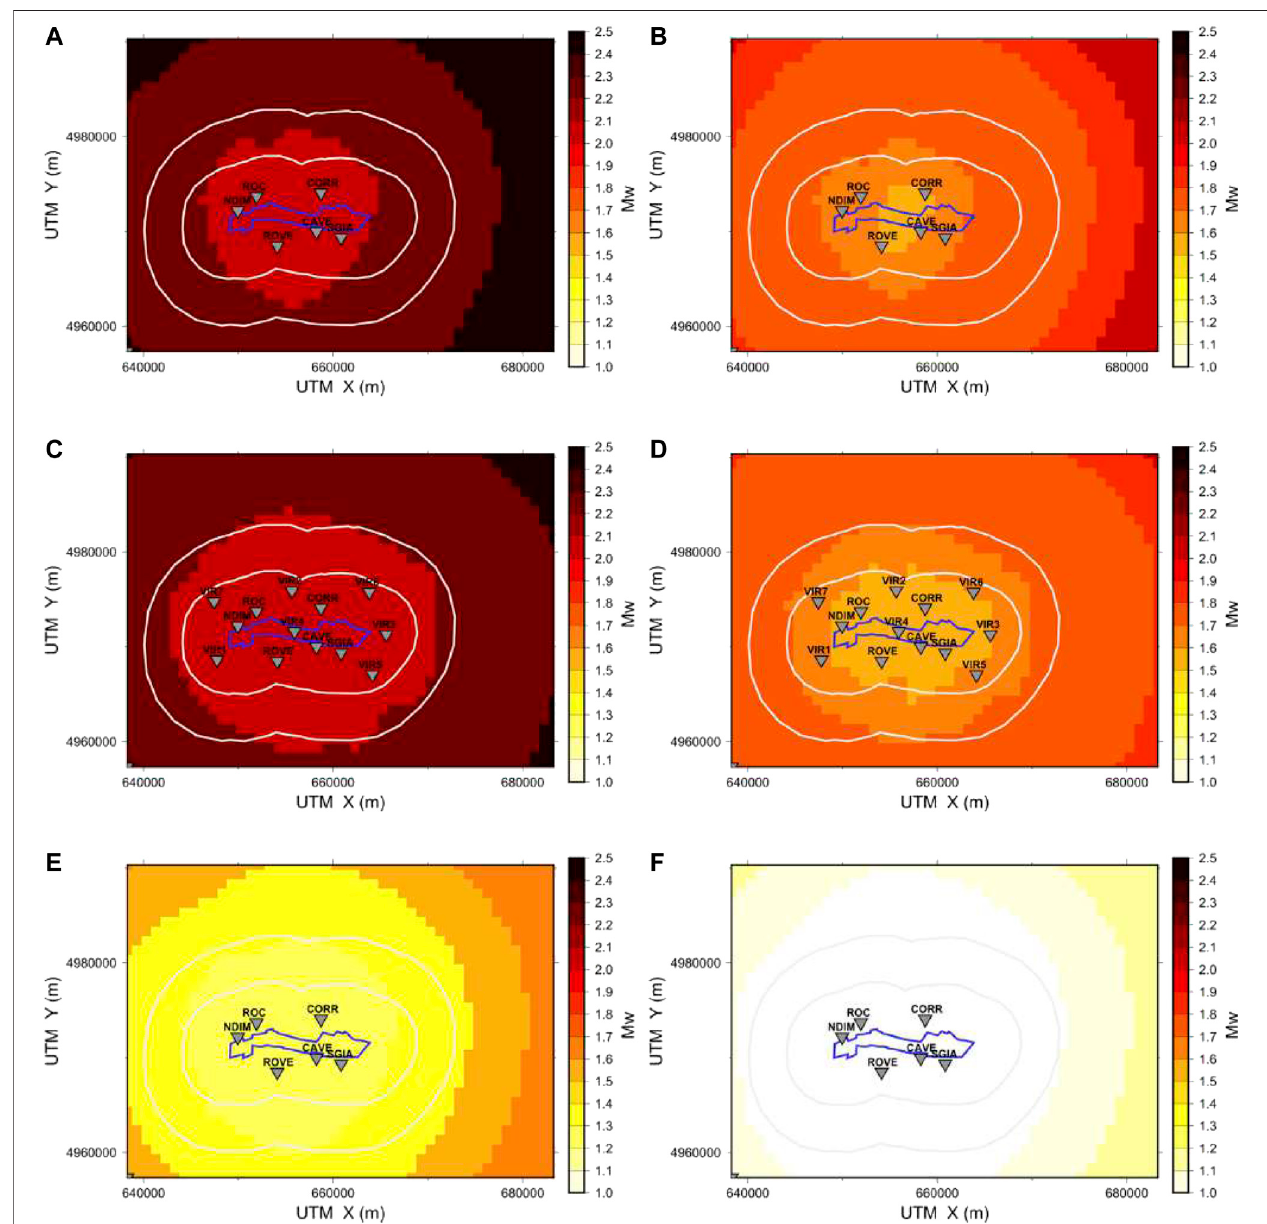
FIGURE 5 | Detection threshold maps for the Cavone oil fi eld area for P and S waves (left and right columns respectively). Panels (A) and (B) report the results for the actual network composed by four VO and two IV stations. The detection thresholds in (C) and (D) are computed for the improved network composed by the six actual stations and seven virtual stations (VIR). The maps in (E) and (F) show the detection thresholds obtained assuming the actual six seismic stations as placed in boreholes at a depth of about 120 m, and considering a reduction in PSD levels (in 1 – 30 Hz range) equal to 25 dB for each station and component.